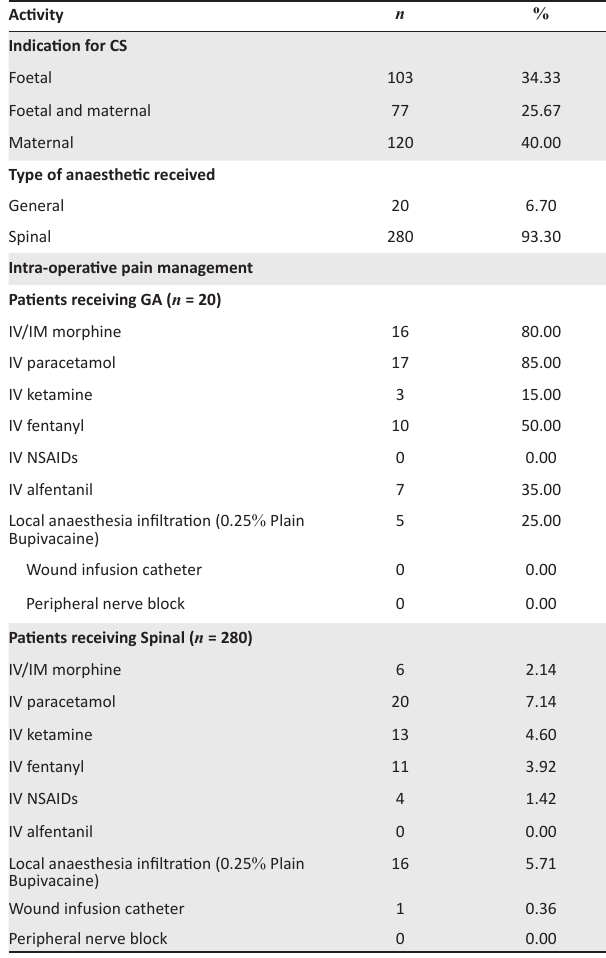
TABLE 2: Management of current caesarean section ( n =